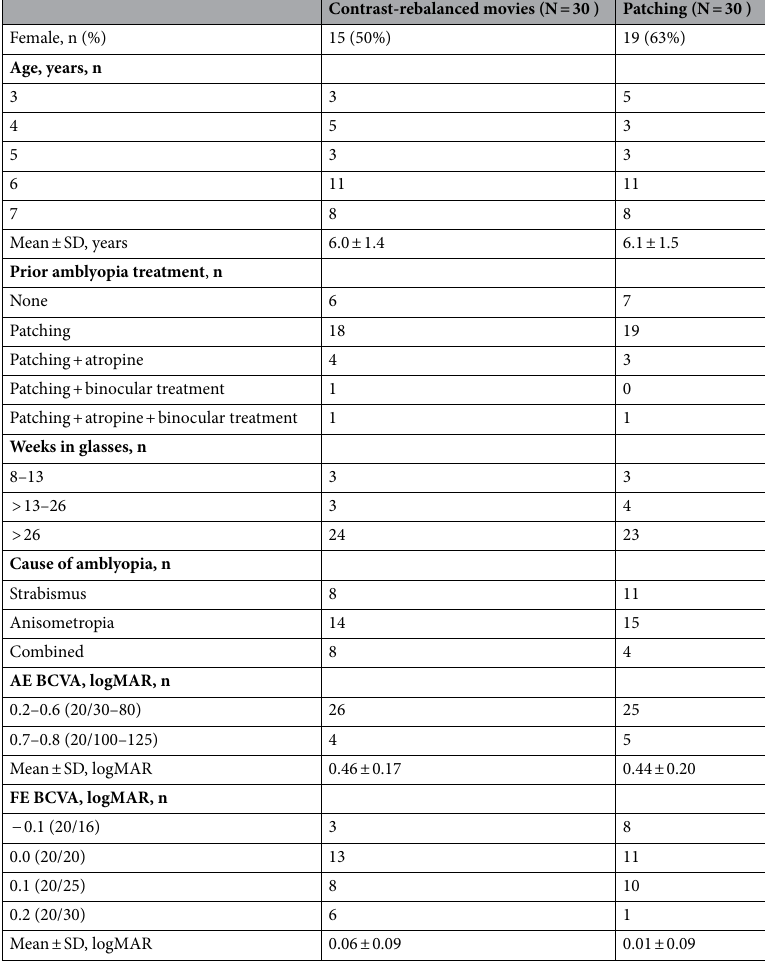
Table 1. Baseline